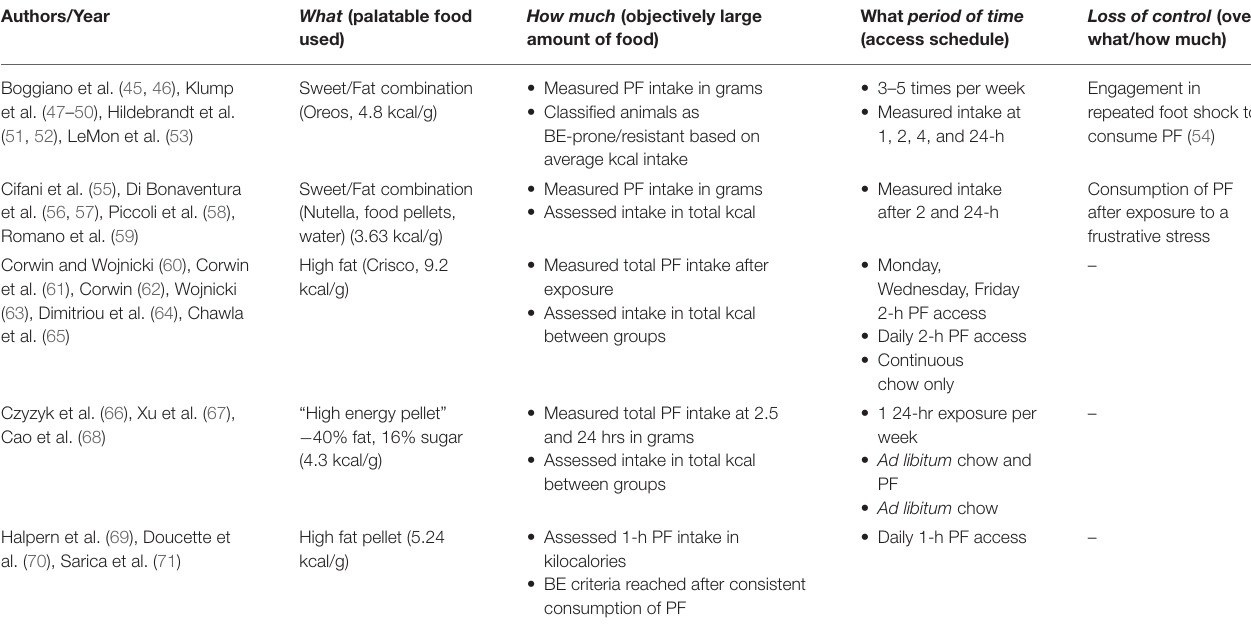
TABLE 1 | Component assessment of selected animal models for binge eating. Authors/Year How much (objectively large